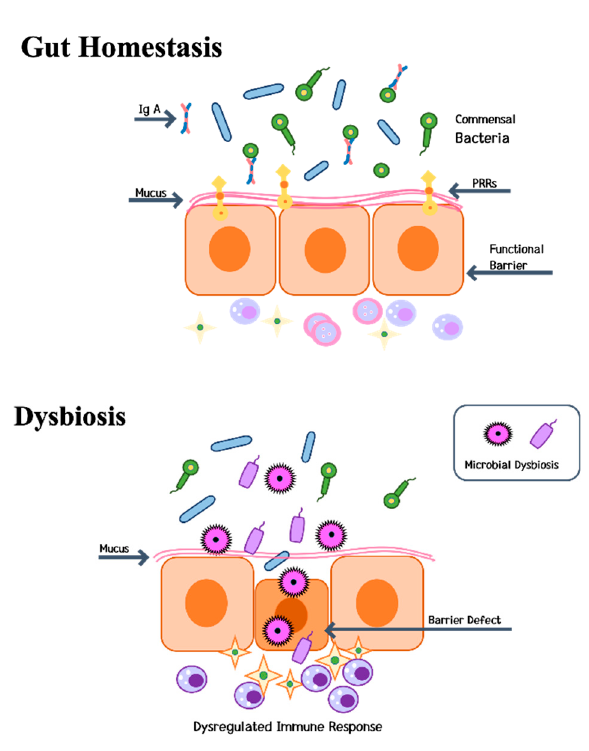
Figure 3. Dysbiosis and gut homeostasis. Dysbiosis has been linked to increased intestinal permeability and a leaky gut. When the balance of the protective bacteria in the intestine collapses and these bacteria are replaced with harmful bacteria, the permeability of the intestinal mucosa is abnormally altered, causing the disappearance of the protective barrier and the induction of inflammation. IgA: immunoglobulin A; PRRs: pattern recognition receptors.